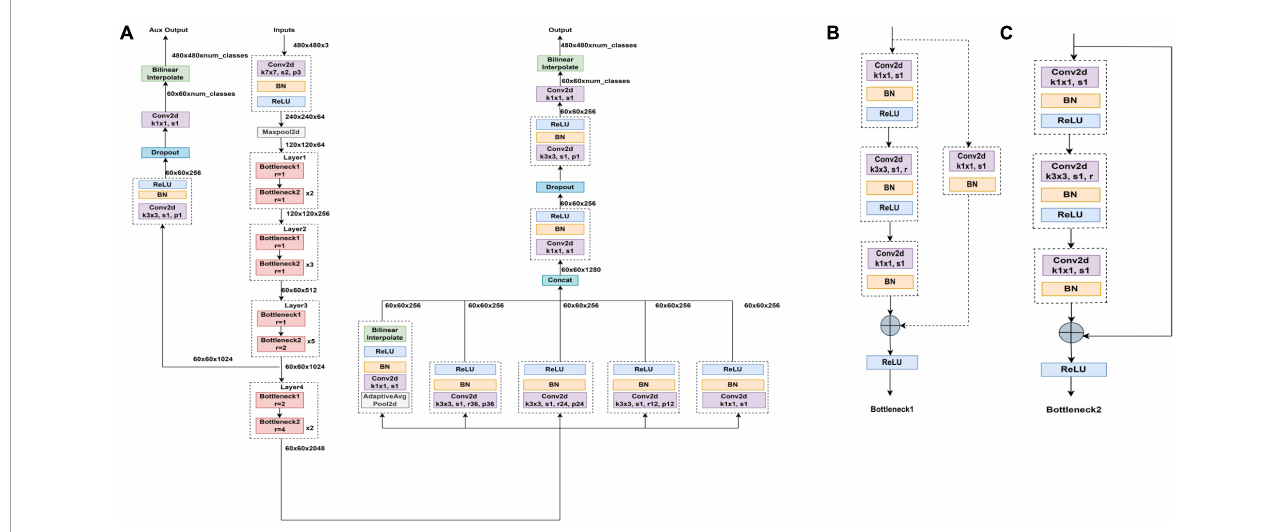
FIGURE3 Segmented network structure diagram (A) Segmented network structure is composed of resnet50 module, ASPP module, and upper sampling. Panels (B,C) are bottleneck1 and bottleneck2, respectively, all of which are composed of several convolutional layers, batch normalization and ReLU.